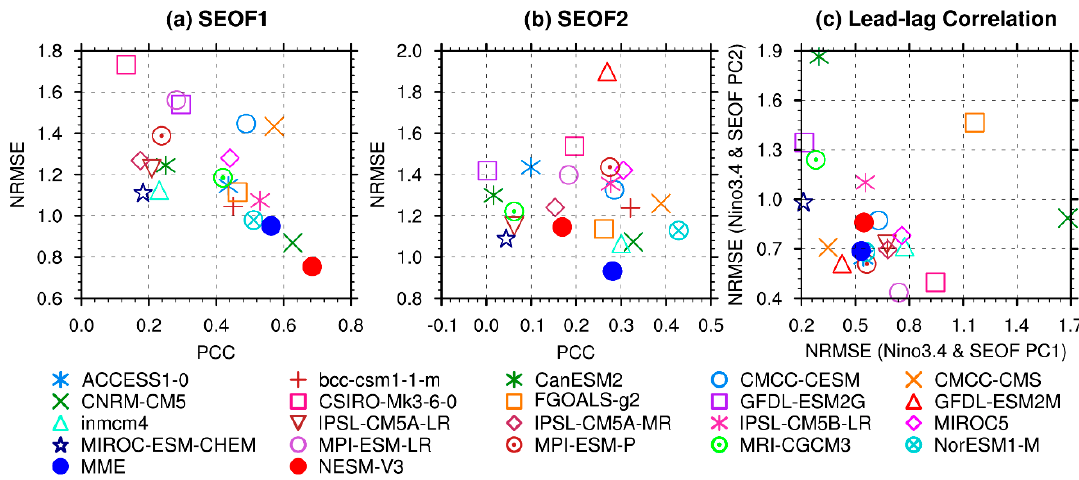
Figure 8. The models’ performance on simulation of ( a ) the first and ( b ) the second SEOF mode of precipitation over the AAM region (30° S–40° N, 60° E–160° E), and ( c ) the temporal evolutions of lead–lag correlation coefficients between Nino3.4 index and the first/second SEOF principle component. The PCC and NRMSE in ( a ) and ( b ) are season-averaged value from JJA(0) to MAM(1).